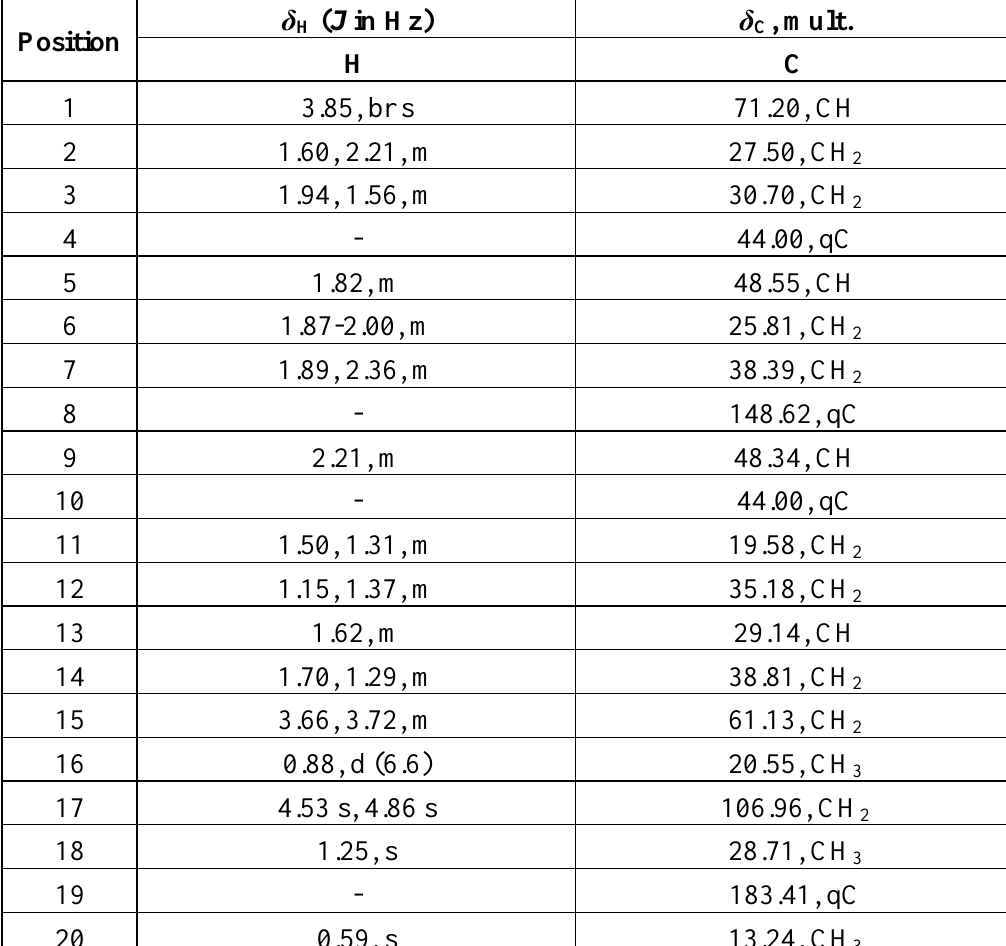
Table 1 . 1 H- and 13 C-NMR data of compound 2 (400 and 100 MHz, respectively, CDCl